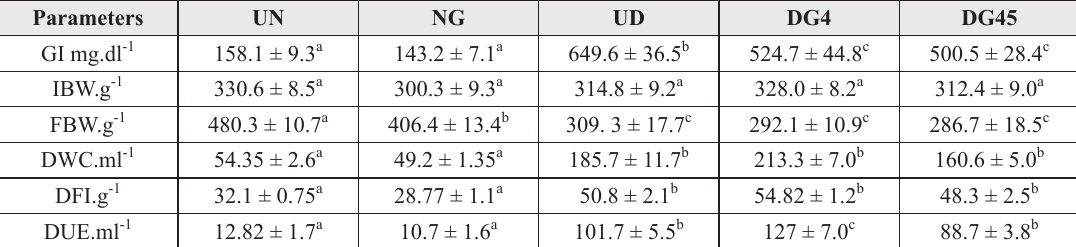
Glycaemia (GI), initial and final body weight (IBW and FBW), daily water consumption (DWC), daily food intake (DFI) and daily urine excretion (DUE) for animals belonging to the following groups: untreated normoglycaemic (UN), glutamine-treated normoglycaemic (NG), untreated diabetic (UD), glutamine-treated diabetic (DG4), glutamine-treated diabetic (DG45). All results are shown as means ± SE. n = 5 rats per group.